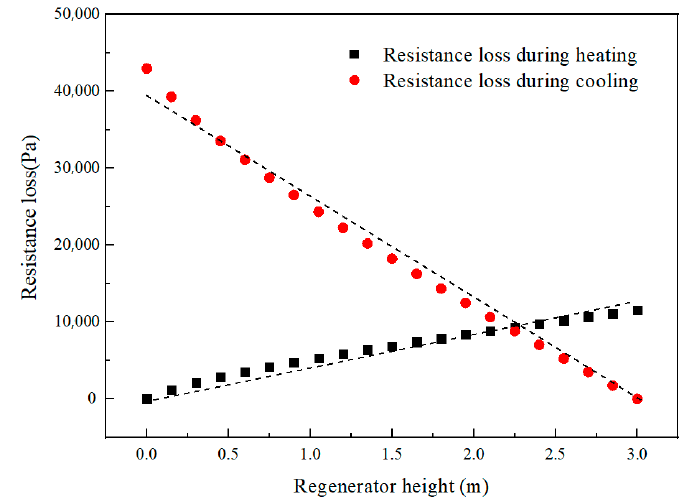
Figure 10. Change curves of the loss of